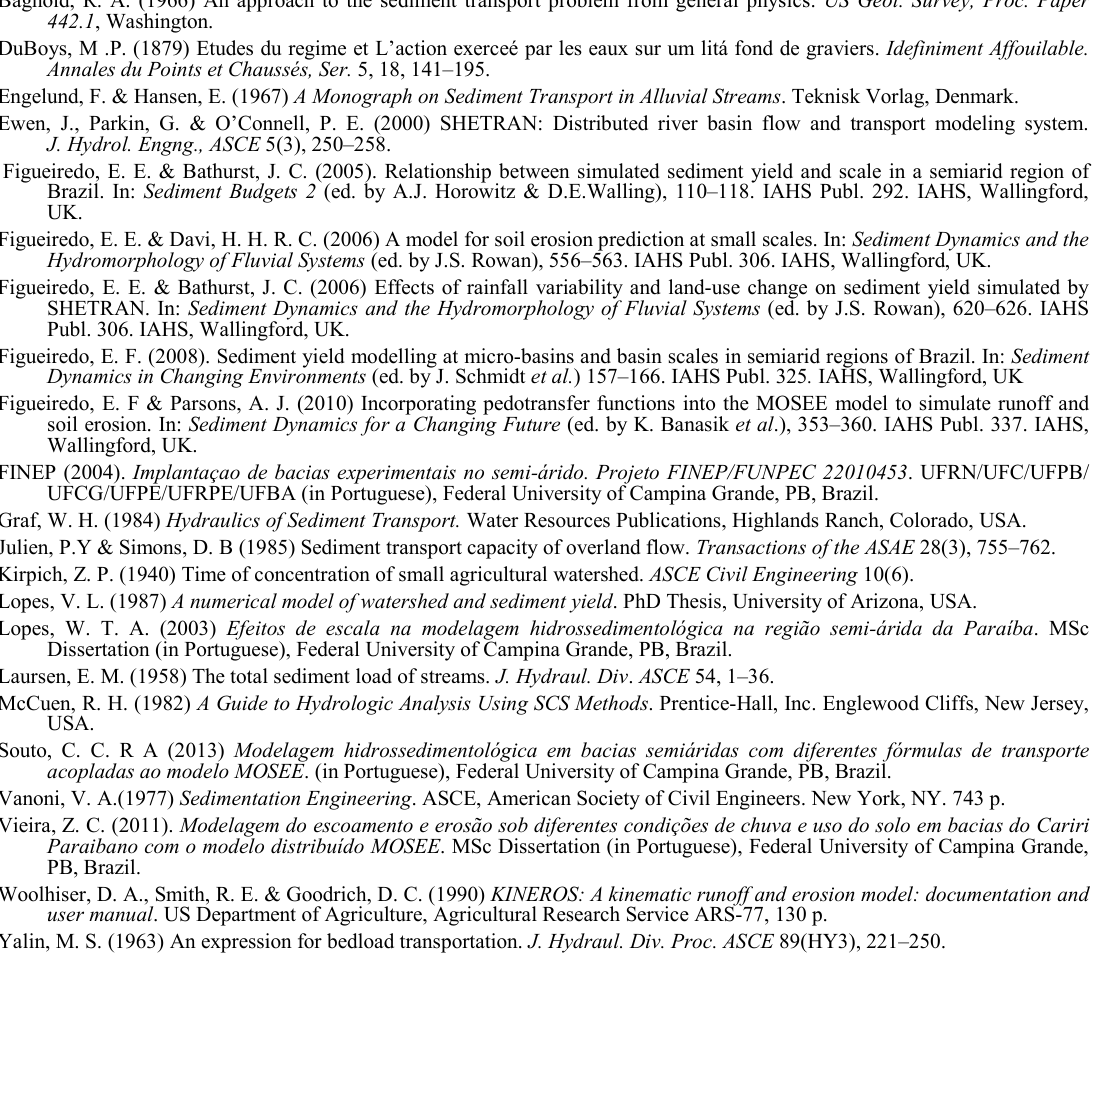
Figueiredo, E. F. (2008). Sediment yield modelling at micro-basins and basin scales in semiarid regions of Brazil. In: Sediment Dynamics in Changing Environments (ed. by J. Schmidt et al. ) 157–166. IAHS Publ. 325 . IAHS, Wallingford, UK Figueiredo, E. F & Parsons, A. J. (2010) Incorporating pedotransfer functions into the MOSEE model to simulate runoff and soil erosion. In: Sediment Dynamics for a Changing Future (ed. by K. Banasik et al .), 353–360. IAHS Publ. 337. IAHS, Wallingford,